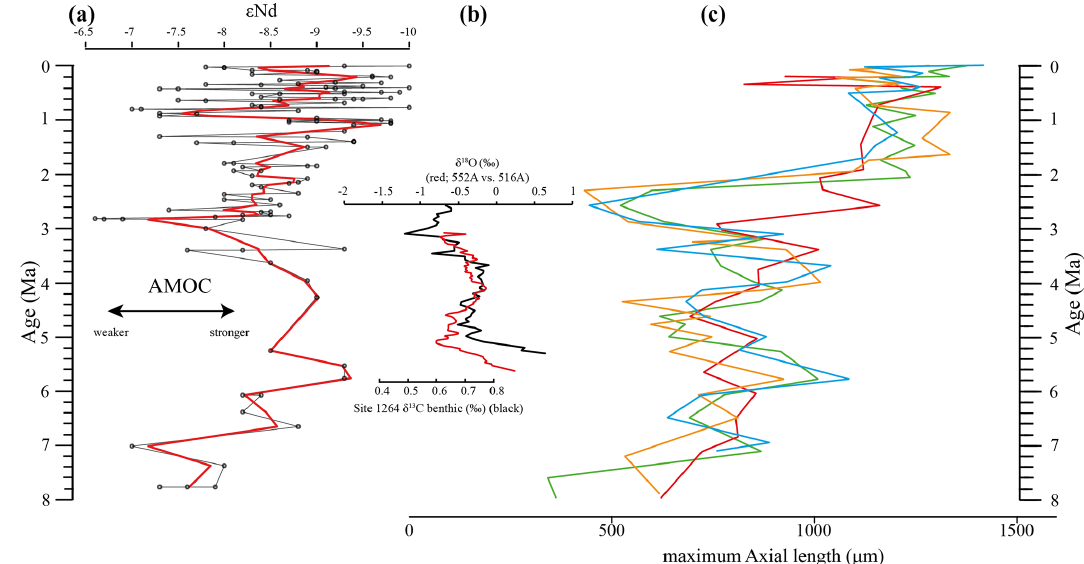
Figure 12. Comparison of seawater Neodymium isotope evolution ( ε Nd), a proxy for the strength of the AMOC, and the maximum axial length of Globorotalia menardii . (a) Dausmann et al. (2017): ε Nd at Site 1088 in the southern Atlantic Ocean. The thin black line shows the original data and the red line a smoothed version, produced with the RStudios’ command “smooth.spline” at the value of 0.35. (b) AMOC strength reconstruction by Karas et al. (2017): the red line represents the δ 18 O seawater gradient of Sites 552A and 516A, while the black one is the benthic δ 13 C curve from Site 1264. (c) Maximum axial length ( δY ) versus age (Ma). The green line represents the size evolution of Hole 667A (eastern tropical Atlantic; this study), orange of Hole 925B (western tropical Atlantic; Knappertsbusch, 2015), blue of Site 502 (Caribbean Sea; Knappertsbusch, 2007b) and red of Site 503 (eastern tropical Pacific; Knappertsbusch,